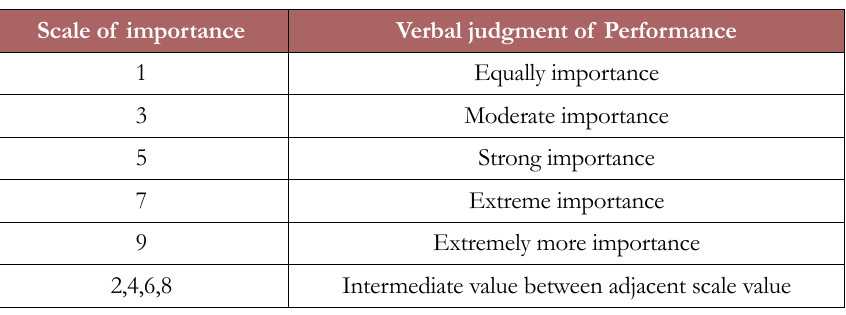
Table 1. Importance scale used in pairwise